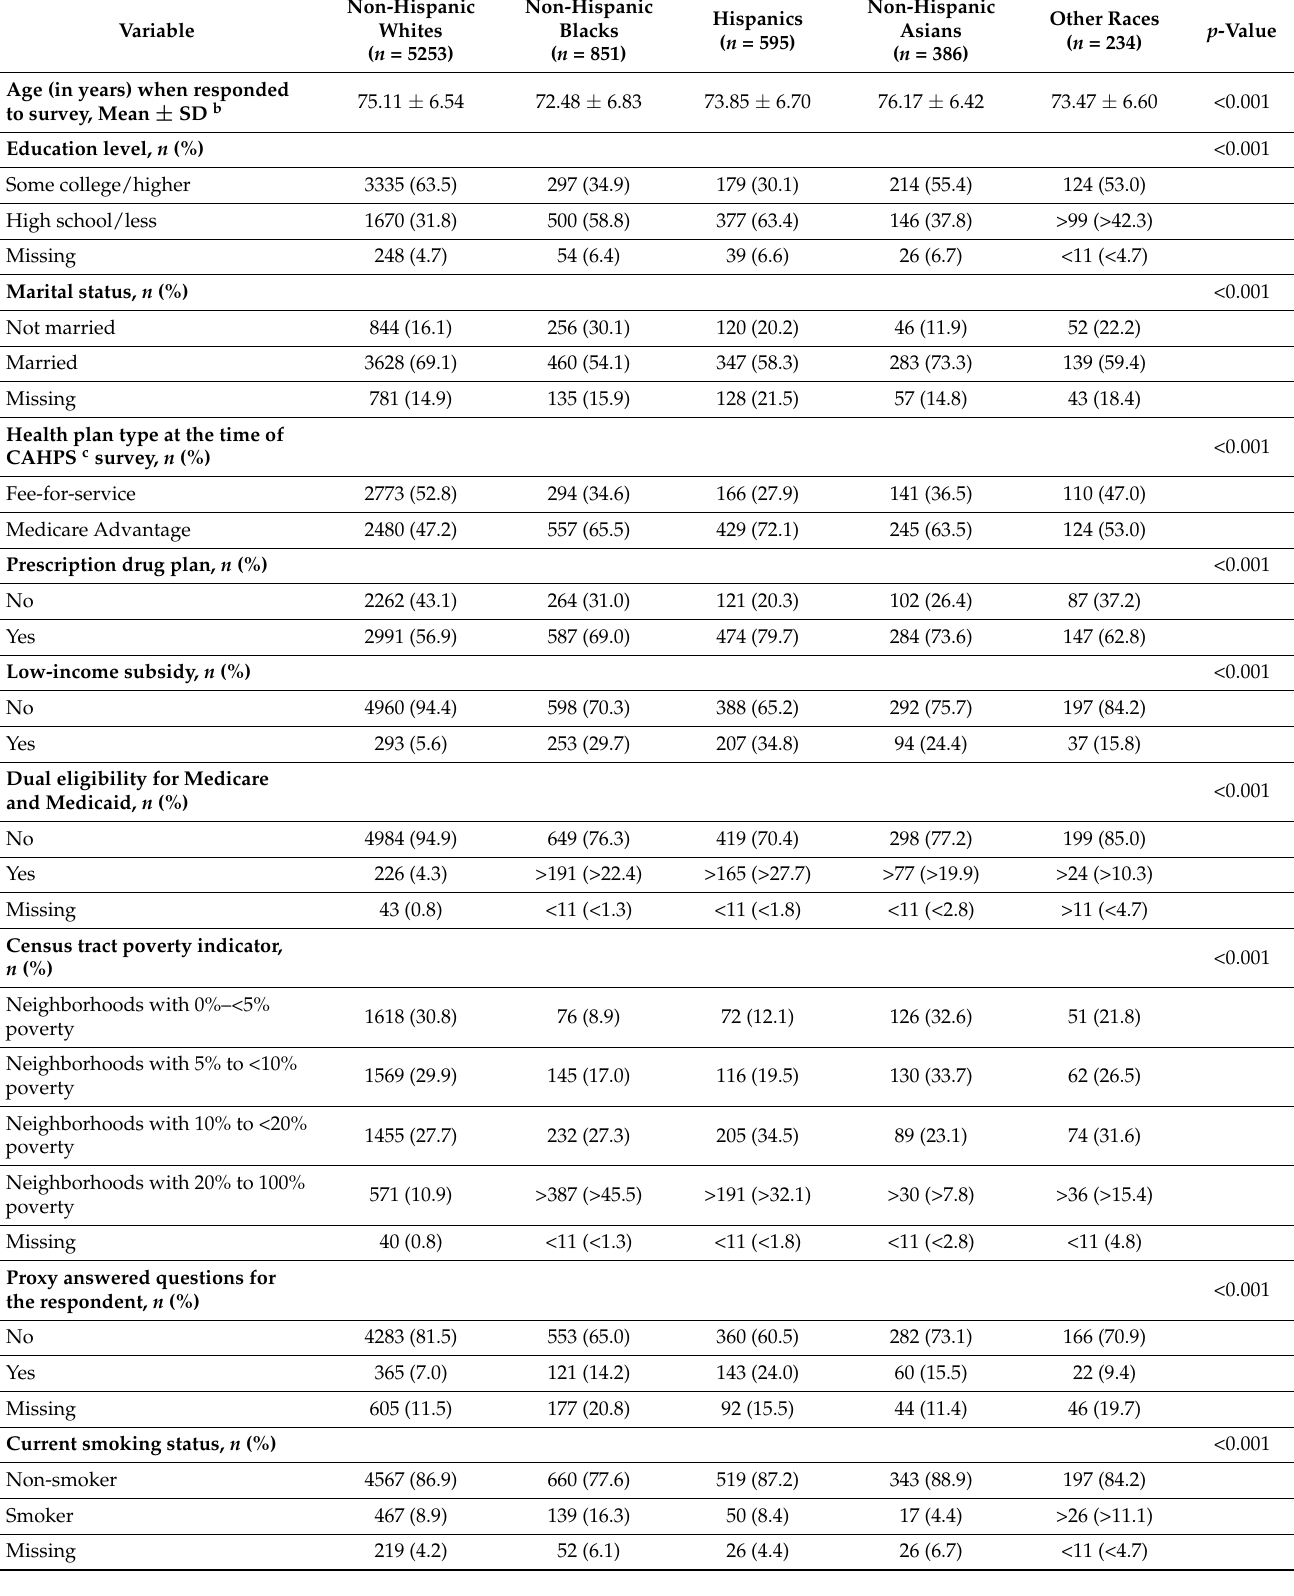
Table 1. Sociodemographic characteristics of study cohort by race/ethnicity a